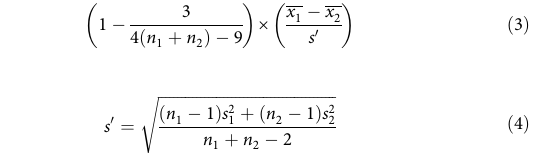
Fig. 2f. In order to compute the contribution of each neurons, we took the 8 × 58 U matrix, and multiplied it by the 58× 244 PCA components to obtain an 8 × 244 weight matrix. We computed the magnitude for all the weights in the matrix, and then normalized them by the largest weight. We then computed the average weight for each of the neurons by taking the average for each column. Neurons were identi fi ed as non-linear mixed selective (NMS), linear mixed selective (LMS), and classically selective (CS) based on a two-way ANOVA with independent variables for target location and trial epoch. Cross-temporal decoding . In order to assess the stability of the population code, we used data at each time point to train a decoder based on Linear discriminant analysis (LDA), built using the classify function in MATLAB, and tested the decoder on data from other time points. One minor difference in the current work was that instead of using normalized z-scored data to decode the target locations, we used projections in the 58 dimensional PCA space (the data we performed the optimization on) identi fi ed using data from Delay 1 and Delay 2 data (full space), projections in a 49-dimensional null space (for Fig. 4), or the projections in the optimized subspace. As we used projections to decode instead of normalized z- scored pseudo-population data, the performance of the decoder in this paper was higher than the results shown in Parthasarathy et al. 14 . For error trials, the decoder was trained on correct trials (similar to the other analyses, but only four out of the